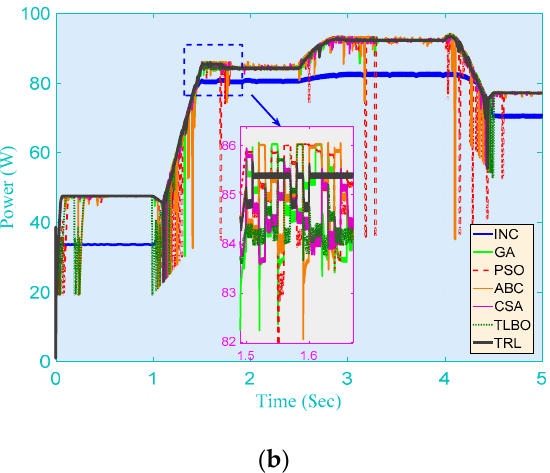
Figure 9. PV system responses of seven methods obtained on the gradual change in both solar irradiation and temperature. ( a ) Voltage; ( b ) Power.